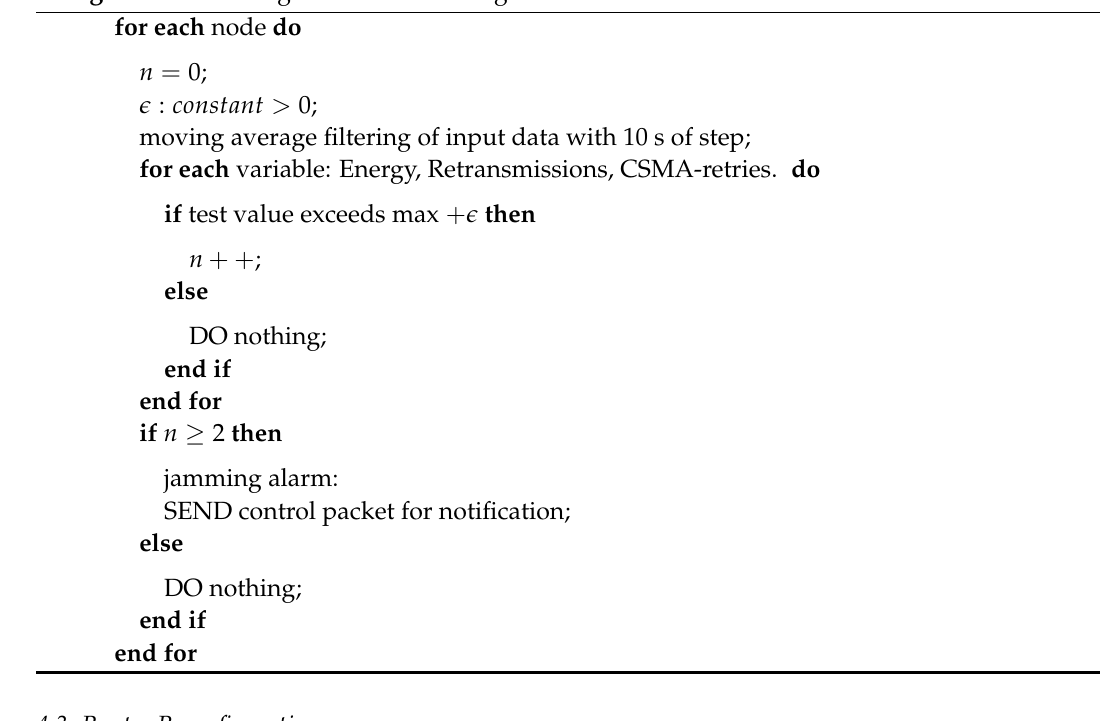
Algorithm 2: Testing of the detection